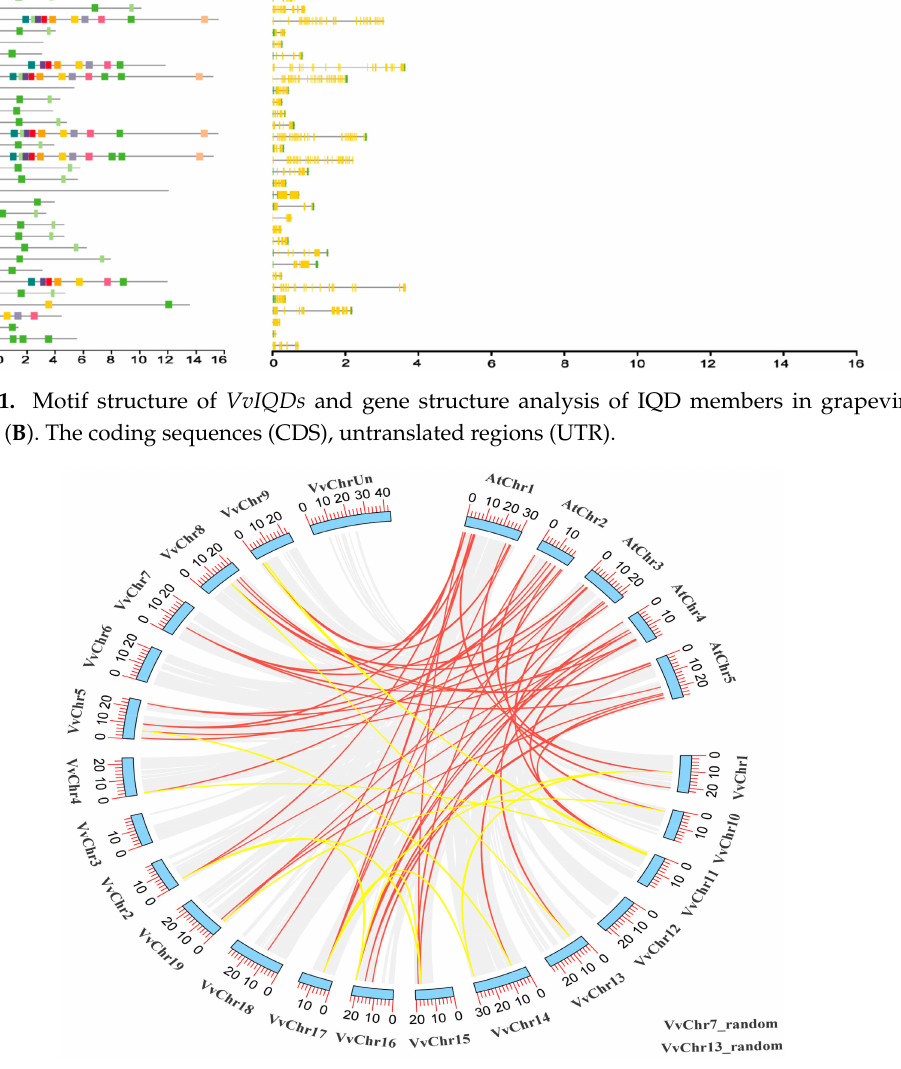
Figure 2. The collinear correlation of VvIQDs between grapevines and Arabidopsis (indicated with red colored lines) and within grapevine (indicated with yellow colored lines). The two random genes in grapevine genes are also given at the